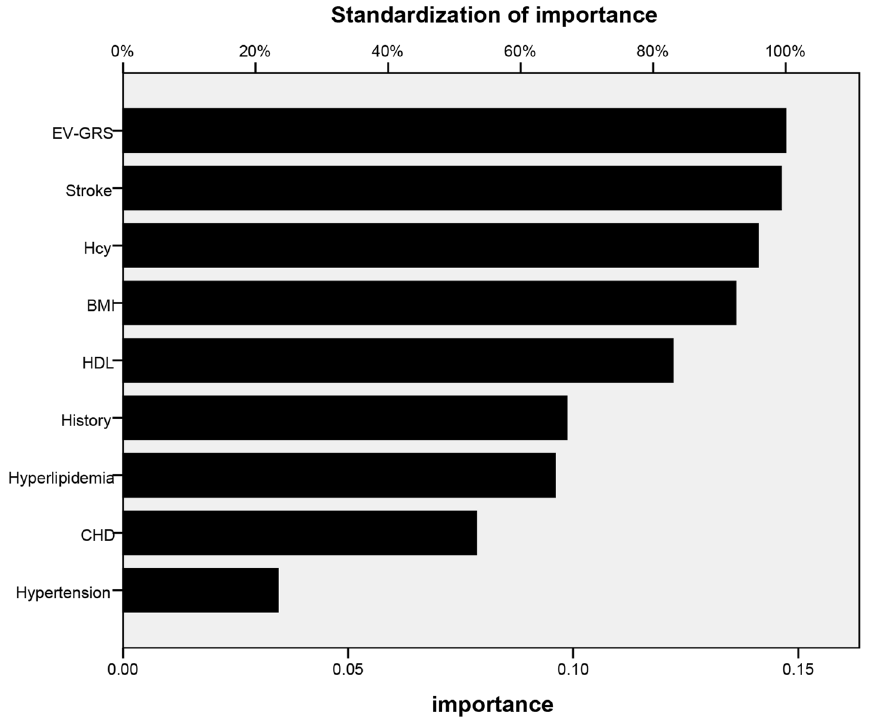
Figure 2. Relative importance of the 9 risk factors to the ANN model. Hcy homocysteine, HDL-C high density lipoprotein cholesterol, EV-GRS explained variance genetic risk score, HL hyperlipidemia, CHD coronary heart disease, HP Hypertension.